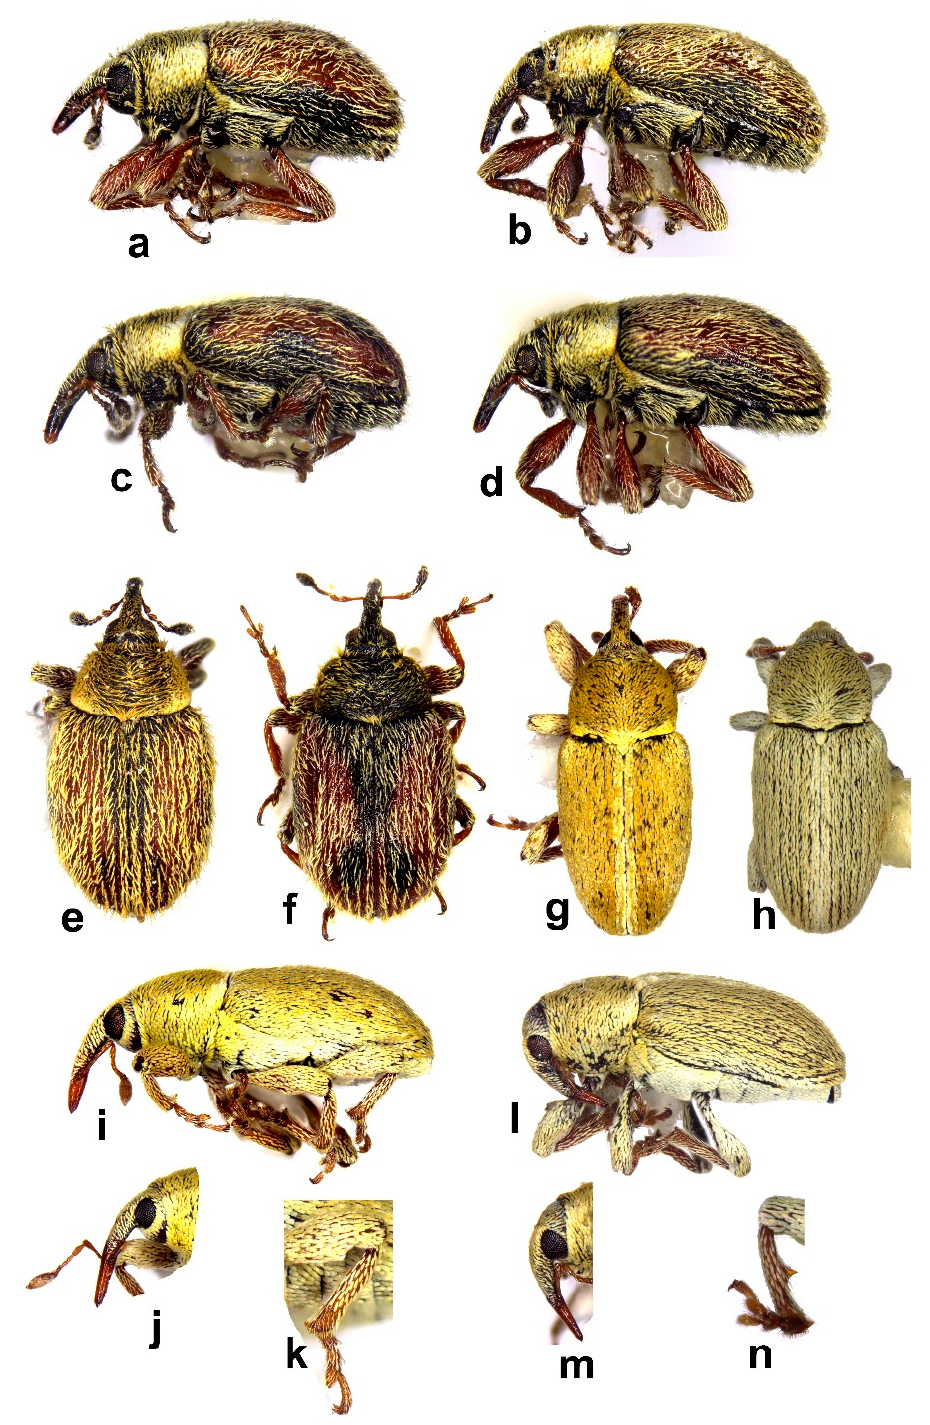
Figure 14. Habitus ( a ) Gymnetron niloticum , male, lateral view; ( b ) G. niloticum , female, lateral view; ( c ) Gymnetron tibiellum , male, lateral view; ( d ) G. tibiellum , female, lateral view; ( e ) G. niloticum , male, dorsal view; ( f ) G. tibiellum , male, dorsal view; ( g ) Tychius bicolor , male, dorsal view; ( h ) T. meliloti, male, dorsal view; ( i ) T. bicolor , male, lateral view; ( j ) T. bicolor , female, lateral view; ( k ) T. bicolor , hind leg, male; ( l ) T. meliloti , male, lateral view; ( m ) T. meliloti , female, lateral view; ( n ) T. meliloti , fore tibia, male (not on the same scale).